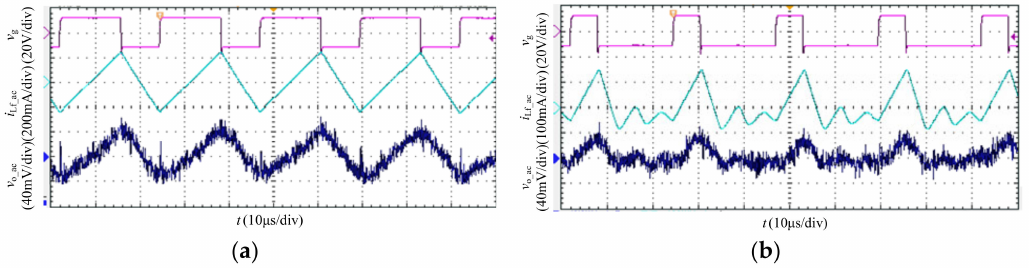
Figure 7. Experimental waveforms of Buck converter before de-noising: ( a ) CCM; ( b )